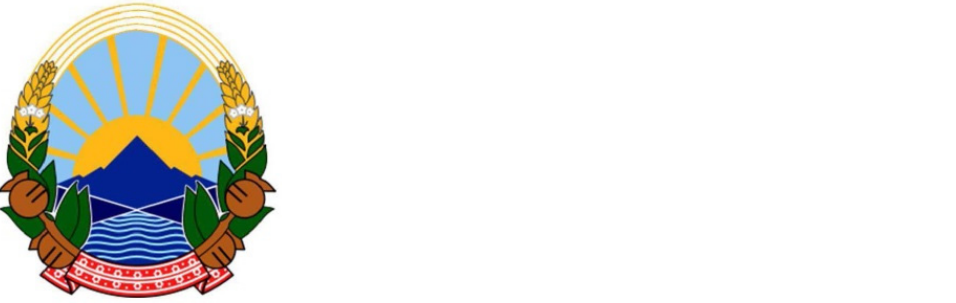
Figure 5. Coat of arms of the Republic of Macedonia adopted in 2009 after the removal of the red star.